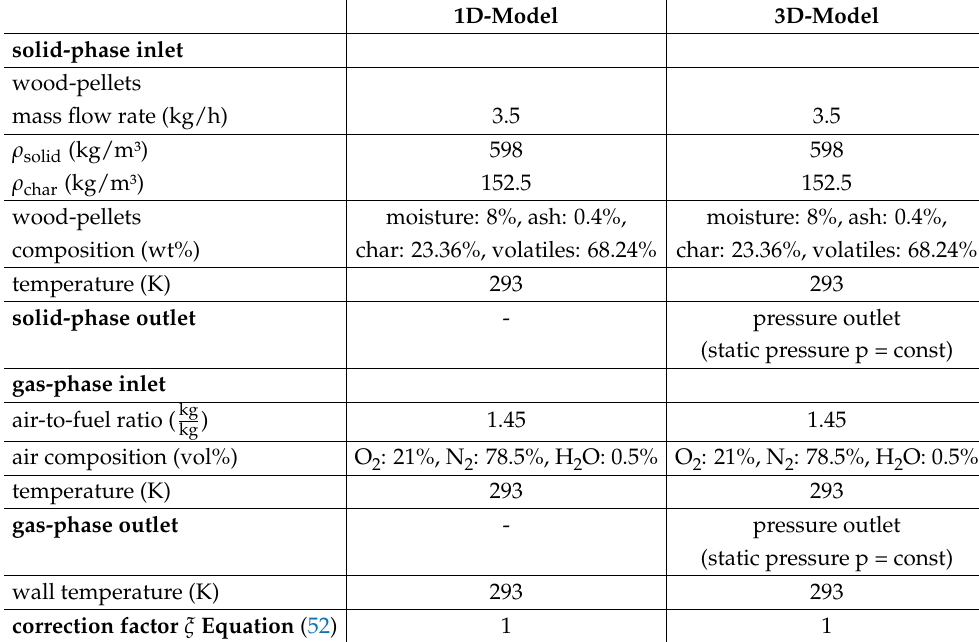
Table 5. Boundary conditions for the 1D- and